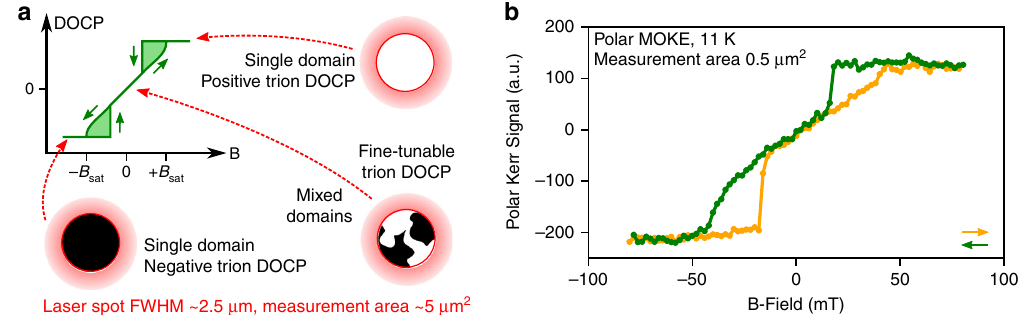
Fig. 4 Domain-like arrangement of trion valley polarization. a Illustration of the trion degree of circular polarization (DOCP), with indications of the spatial arrangement of trion valley polarization at various points on the curve. Above ∣ B sat ∣ , the CrBr 3 is in a single domain state and there is a uniform spin preference for electron tunneling from MoSe 2 to CrBr 3 . At lower B - fi elds, the relative strengths of spin ↑ or ↓ tunneling may be fi ne-tuned by control of the external fi eld, which determines the relative spatial area occupied by adjacent domains. The red circles indicate an approximation of the laser spot area in the PL study, about 5 μ m 2 , over which the domain behavior is averaged. b Polar magneto-optical Kerr effect (MOKE) signal from the same sample, with a much smaller measurement area of 0.5 μ m 2 . The domain nucleation behavior is retained, indicating a very small length scale of